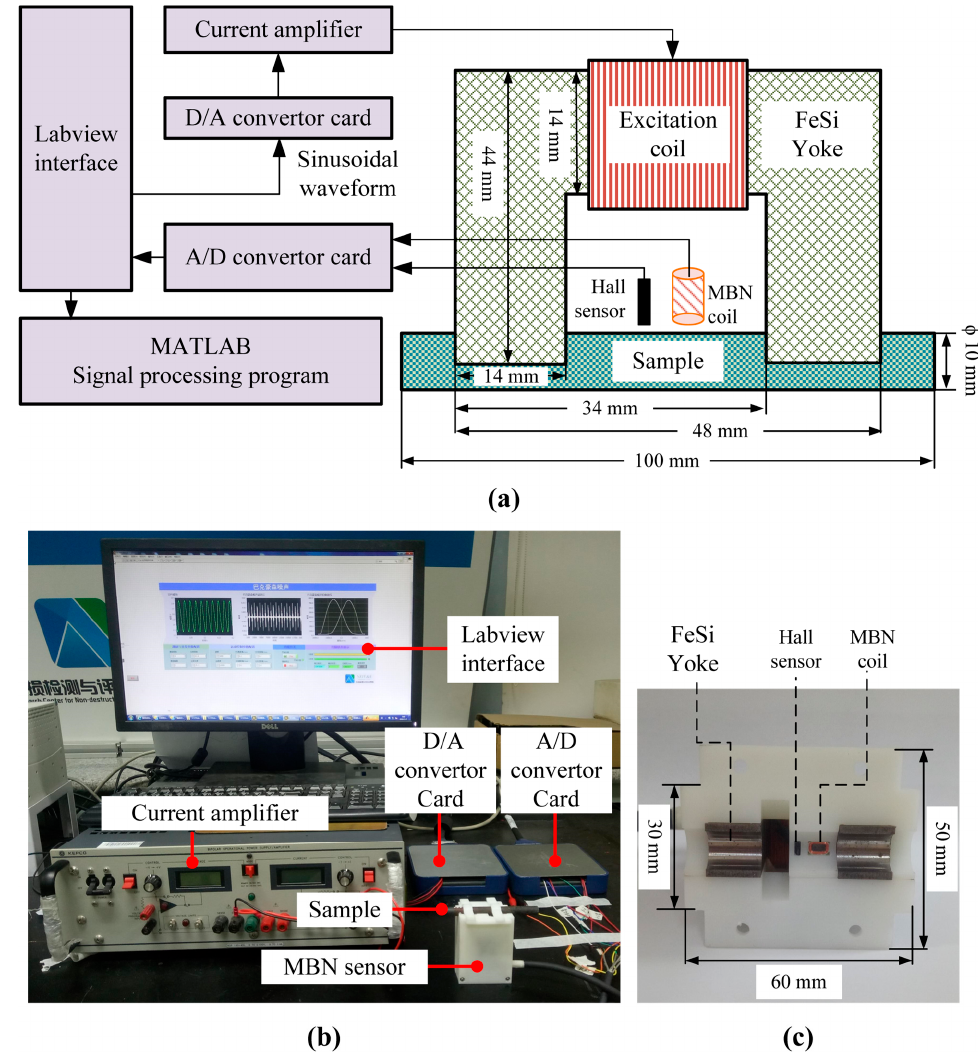
Figure 1. ( a ) Schematic diagram (not to scale), photograph ( b ) of the experimental set-up for MBN measurements, and ( c ) cross-section of the MBN sensor.